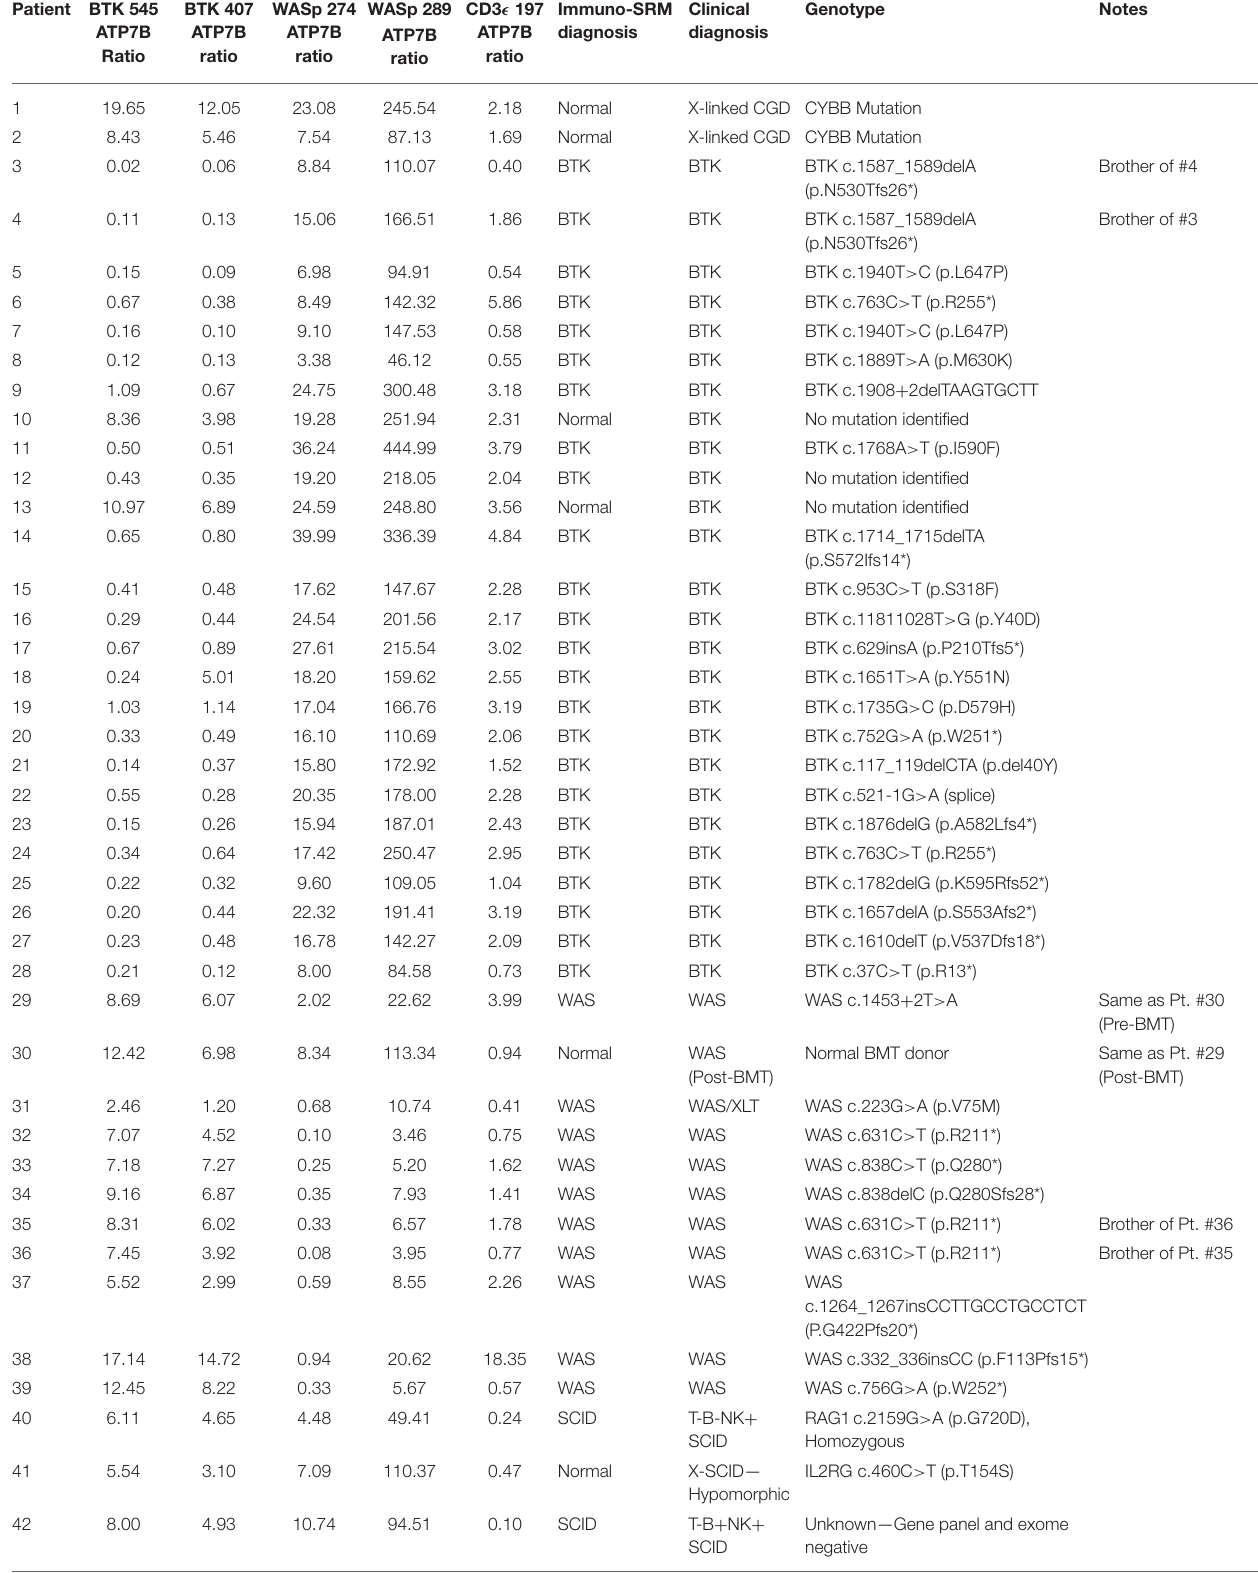
TABLE 8 | Ratios of signature peptides against ATP7B peptide and patient diagnosis in a blinded cohort study. Patient BTK 545 ATP7B